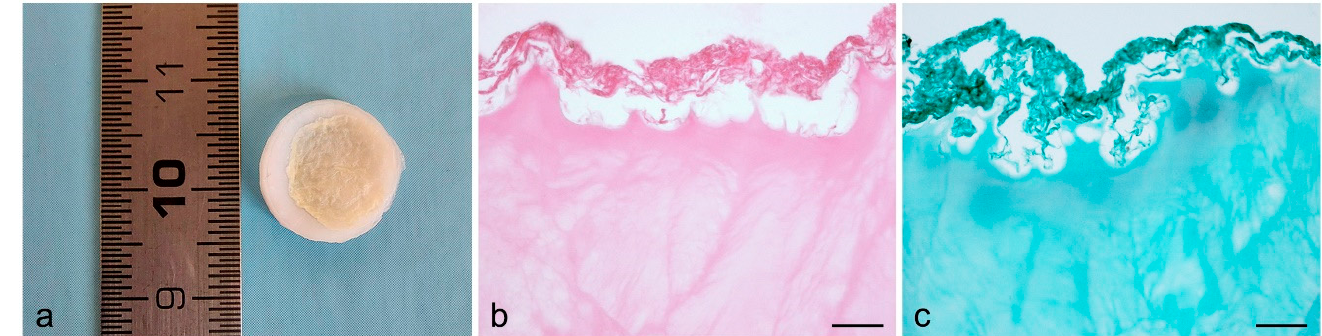
Figure 3. Gross appearance ( a ) and histological morphology ( b , c ) of PVA/AC composite scaffolds after hematoxylin and eosin ( b ) and Masson’s trichrome ( c ) staining. Human AC was decellularized, homogenized, and lyophilized to obtain a thin matrix layer which was crosslinked onto PVA scaffold by freeze-thawing. Scale bar: 50 µm.